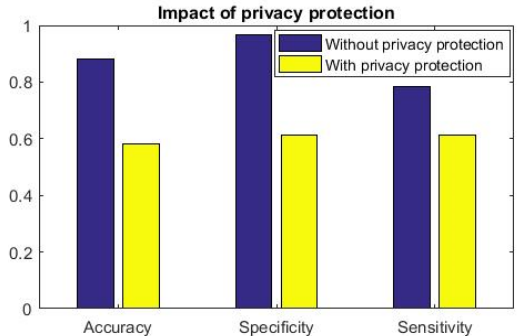
Figure 7. Clinical analytics results of the proposed data-driven method and impact of privacy preservation. It shows that the proposed inferential analytics method (result of without privacy protection when shared data is F test ) produces significant clinical e ffi cacy (inference I ) : Accuracy, sensitivity, specificity all more than 0.8. Our proposed privacy preservation technique obfuscates the features such that clinical e ffi cacy (inference I Prv ) on obfuscated data F Prv drops significantly (almost test random outcome, performance of merit → 0.5 when inference decision is made while protecting